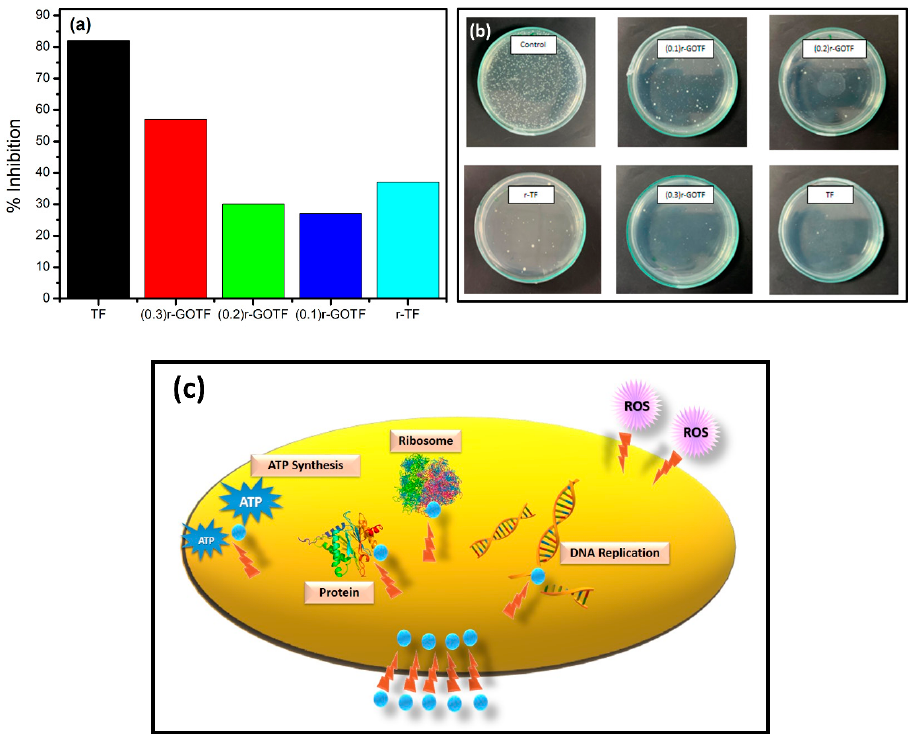
Figure 10. ( a ) Percentage inhibition of E. coli by fabricated nanocomposites, ( b ) sterilization perfor- mance of E. coli nanocomposites and ( c ) suggested photosterilization mechanism.